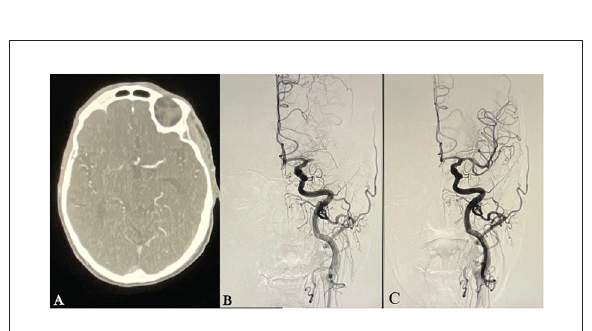
FIGURE3 Imaging of a patient without a “Tilted-V Sign.” (A) Axial images of CT angiogram of head showing lack of flow beyond the occluded M1-Middle Cerebral Artery (MCA) segment without filling of proximal M2 segments of the middle cerebral artery (MCA). (B) Digital subtraction angiography (DSA) before endovascular thrombectomy (EVT) showing complete occlusion of the M1-MCA segment but without visualization of vessels distal to the occlusion. (C) DSA following EVT showing successful